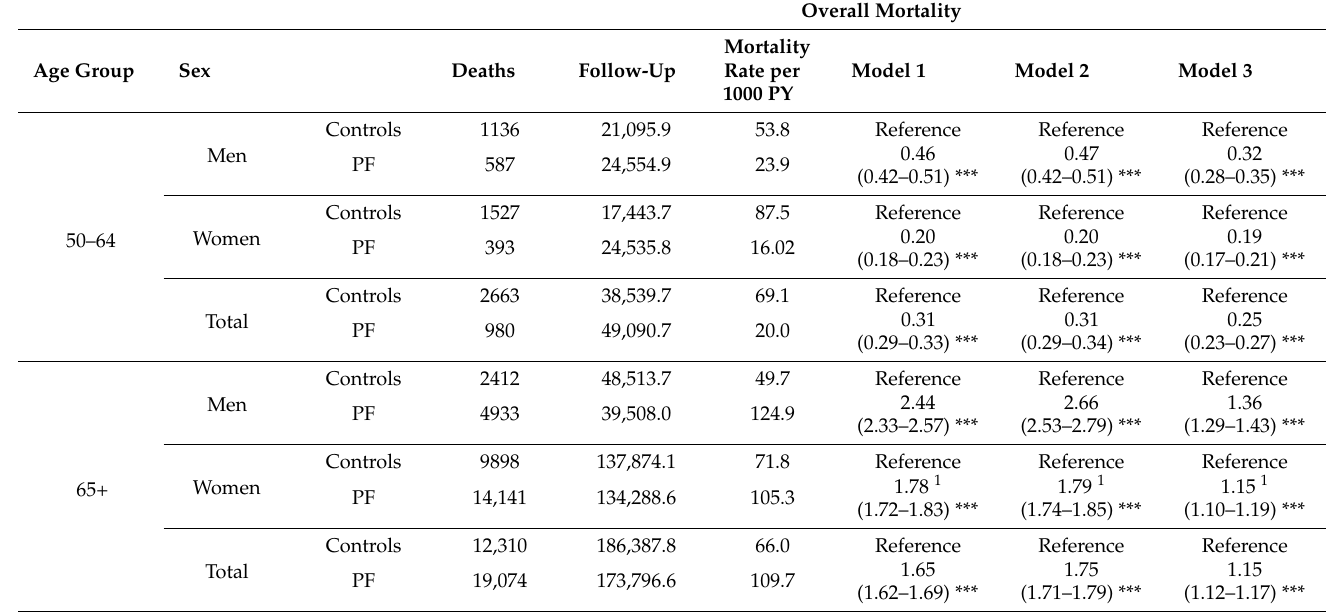
1 Results of logistic regression analysis; the numbers represent odds ratios. *** p < 0.001. Model 1: crude, Model 2: adjusted for age at index date, Model 3: adjusted for weighted EHI (continuous variable). There were significant differences in overall survival probability by sex and age group